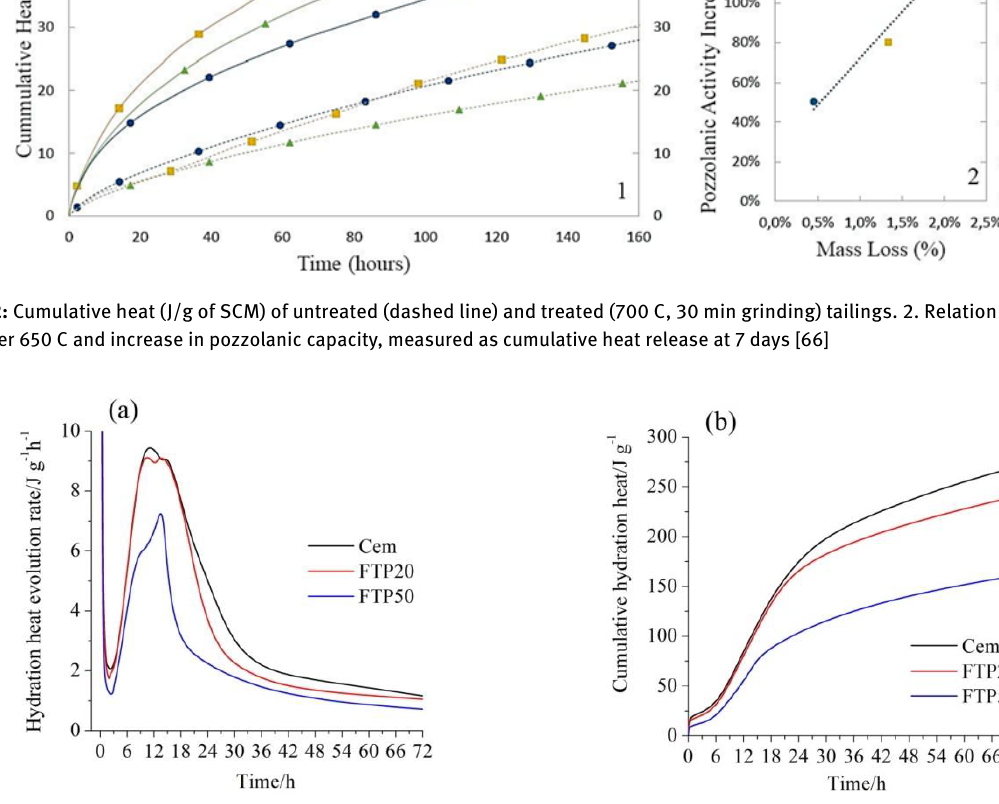
Figure 13: The heat of hydration cement paste containing fine tailings at w/c ratio of 0.4 [58]